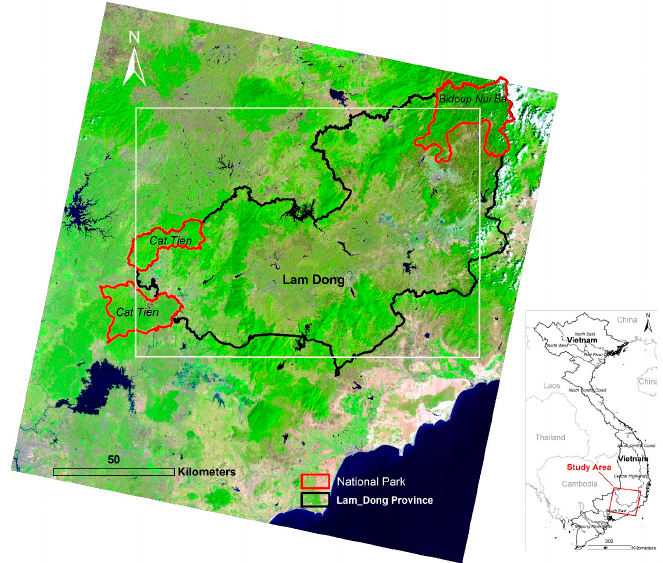
Figure 1. Boundary of Lam Dong Province superimposed on Landsat imagery. The boundary locations of two national parks within the region are also shown on the image in red. The white box indicates the area shown for many of the following figures. This image, as well as the following “green” images, were produced using a red green blue (RGB) composite of Landsat’s shortwave infrared 1, red, and green bands in the order of red, green and blue.